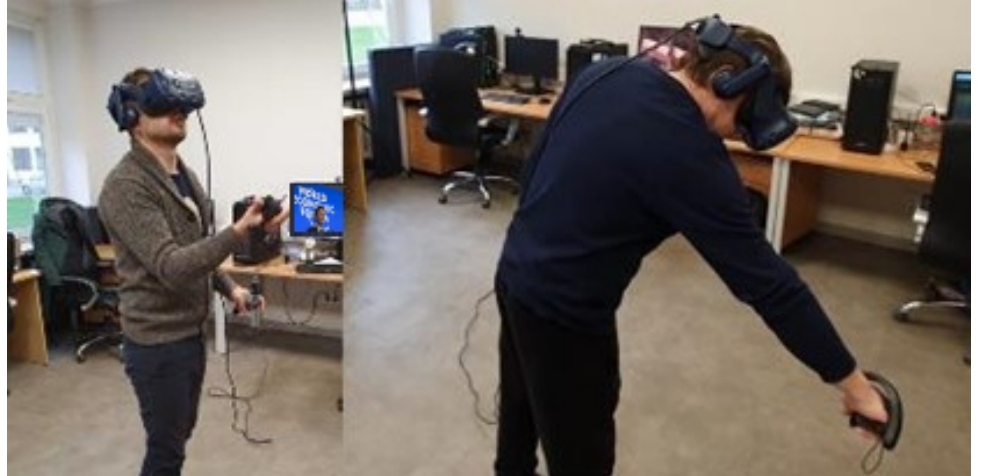
Figure 8. Respondents trying the VR program during the testing of the application, experienc- ing genuine cross-cultural communication and friendships to transcend differences, stimulating innovative thinking and creative new modes of collaboration to build a more positive, peaceful, and successful